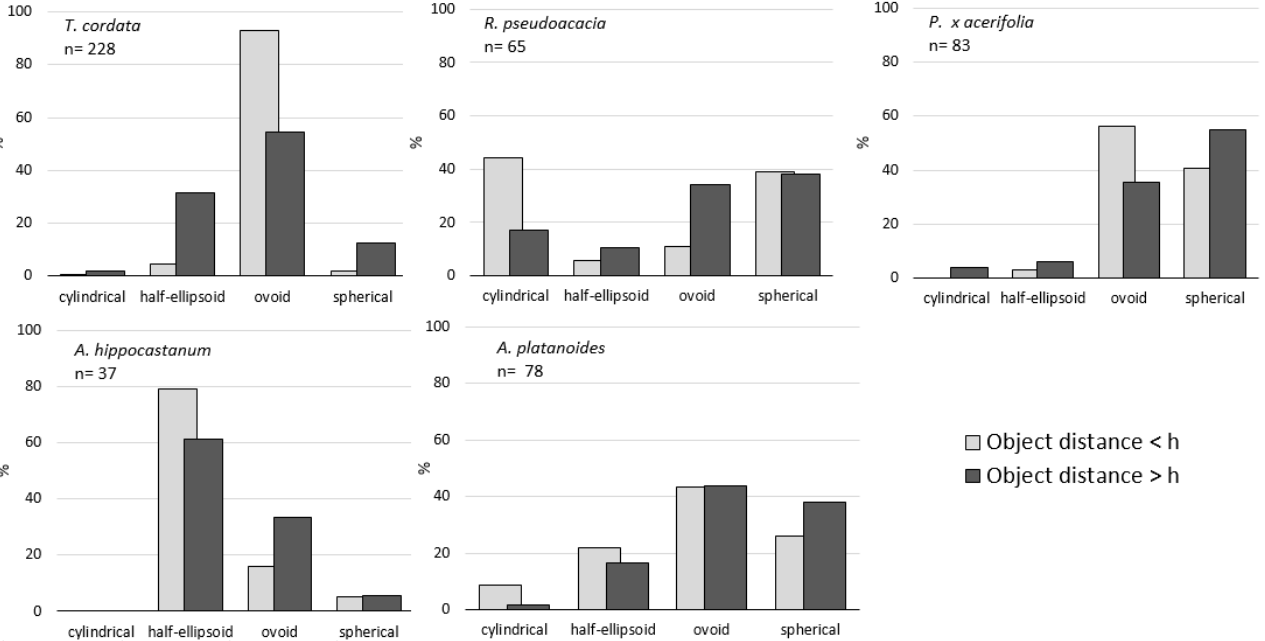
Figure 7. Percentage distribution of crown shapes of all trees for two distance classes of the closest object.